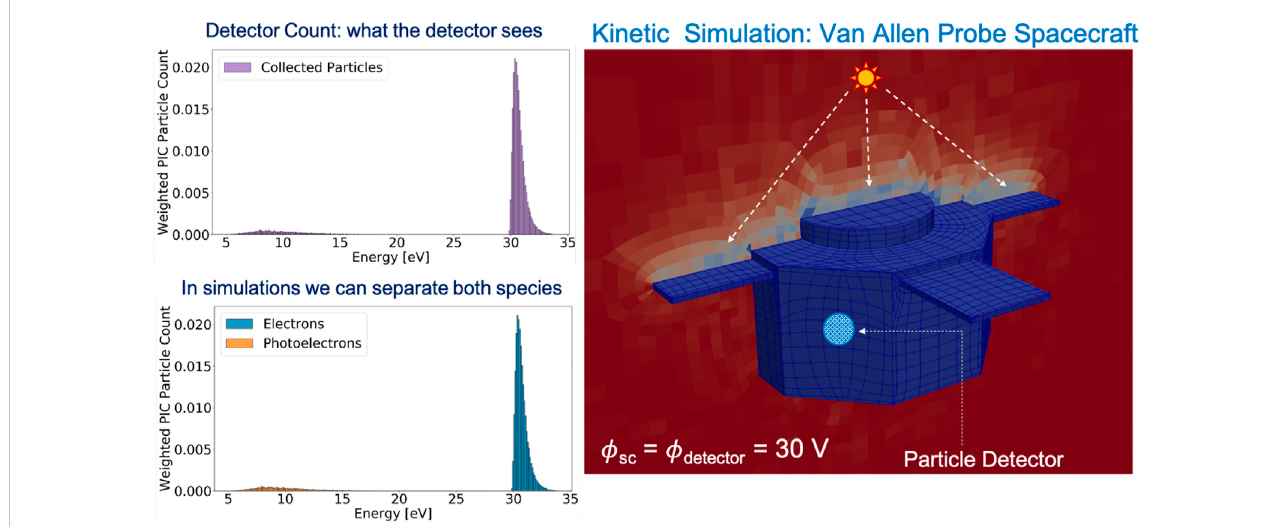
FIGURE 6 Kinetic simulation result: active spacecraft control enables cold-electron measurements. Cold-electron and photoelectron populations are clearly separated in detector signal as shown inthe top-left panel and con fi rmedinthe bottom-left panel. Simulation inputs: n (cid:2) 13.5 cm − 3 , T e (cid:2) 0 . 5 eV T i =0.35 eV, T ph (cid:2) 2 eV and J ph = 100 μ A/m 2